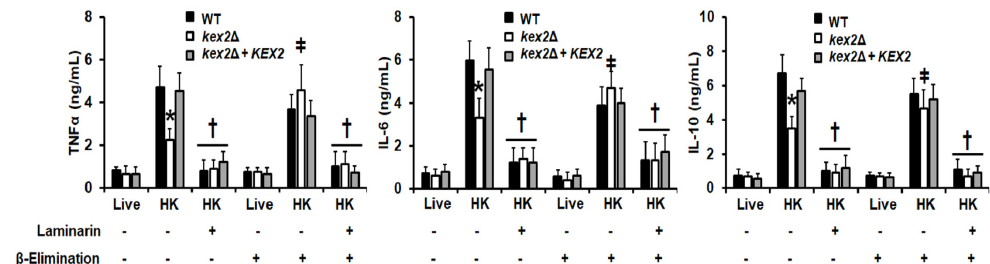
Figure 4. Cytokine production by human peripheral blood mononuclear cells stimulated with Candida albicans kex2 Δ null mutant and control strains. Live or heat-killed (HK) yeast cells and human peripheral blood mononuclear cells were co-incubated for 24 h, the supernatant saved and used to quantify the levels of secreted TNF α , IL-6, and IL-10. Results (means ± SD) were obtained using samples from eight donors, each assayed in duplicate wells. * P < 0.05, when compared with live cells under the same treatment; † P < 0.05, when compared with HK cells without preincubation with laminarin; ‡ P < 0.05, when compared to cells without β -elimination treatment. Strains used are NGY152 (WT), HMY209 ( kex2 Δ ), and HMY210 ( kex2 Δ + KEX2 ).